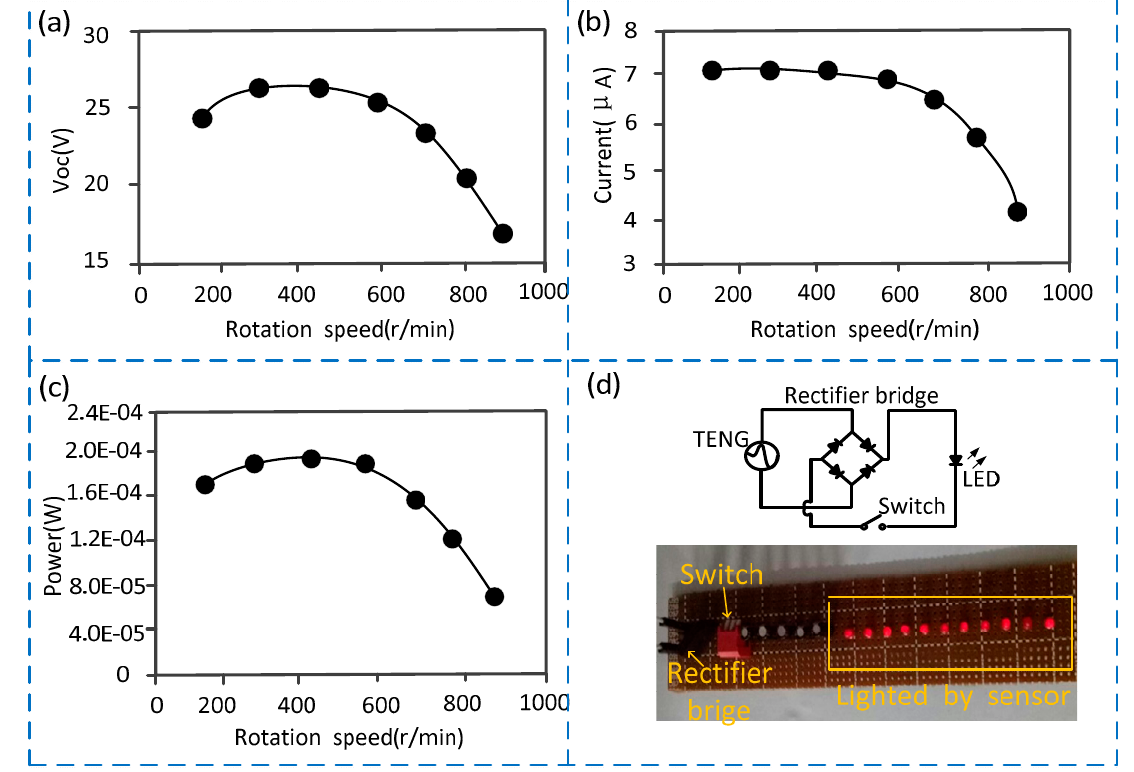
Figure 5. Experimental results of the self-powered sensor. ( a ) Curve showing the relationship between the output voltage and the rotational speed; ( b ) curve showing the relationship between the output current and the rotational speed; ( c ) curve showing the relationship between the output power and the rotational speed; ( d ) a picture shown the LED (light emitting diode) lighted by the sensor’s output power.